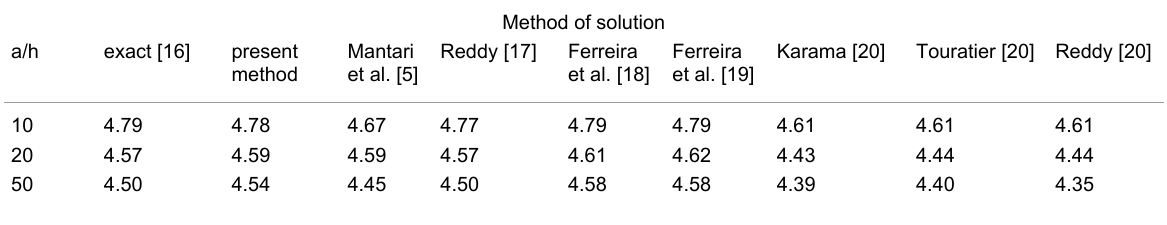
Table 1: Transverse deflections for square macro plate under uniform load.